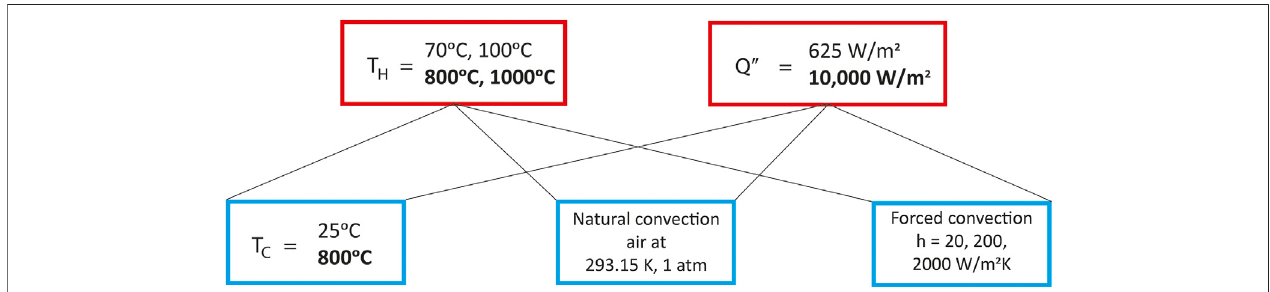
FIGURE3| Hot andcoldsideboundaryconditionscenariosmodeledforalloftheleg shapes.Each hotsidecondition(constanttemperature orconstantheat fl ux, in red boxes) was modeled with each cold side condition (constant temperature, natural convection, and three forced convection coef fi cients h , in blue boxes). When different values were used based on the thermoelectric material, the designation is indicated with regular font for bismuth telluride and bold font for silicon germanium. The boundary condition combinations applied to the nine leg shapes shown in Figure 2 resulted in 270 simulations, 135 for bismuth telluride and 135 for silicon